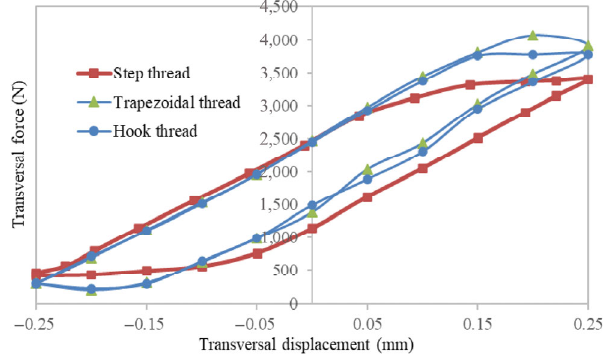
Fig. 17 Relationships between transversal forces and transversal displacements under different thread